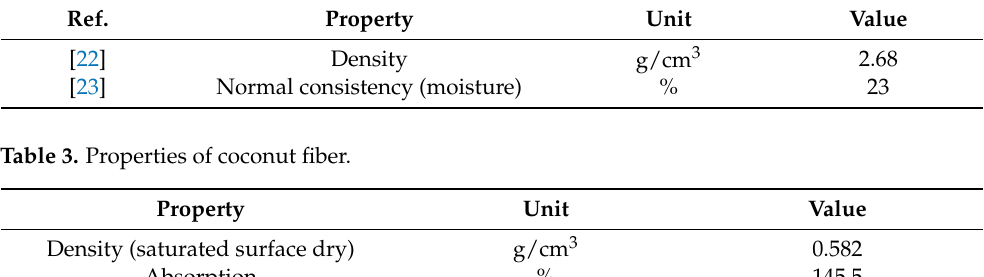
Table 2. Properties of concrete.